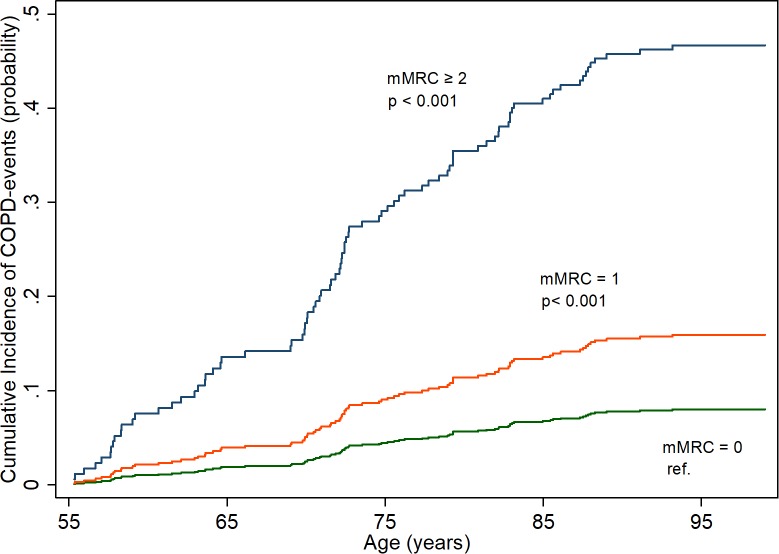
Risk of chronic obstructive pulmonary disease (COPD) events (hospitalisation, out-clinic diagnosis or diagnosis from death-certificate) per modified Medical Research Council (mMRC) grade from age 55 throughout life.Calculated using competing risks regression.